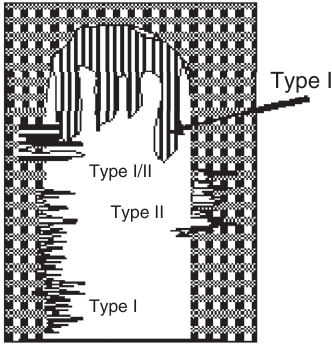
Figure 1 Types of delamination in fiber-reinforced